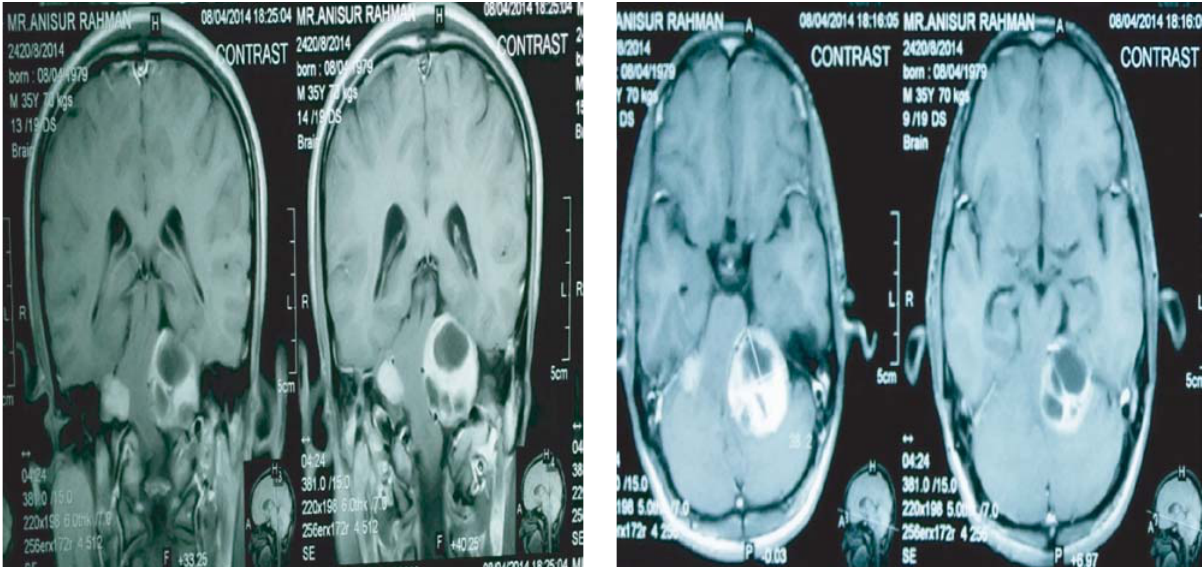
Fig 2. Post-contrast MRI shows well defined, enhancing, large heterogeneous and cystic mass in left CP angle and also a small mass in right CP angle extending in left internal auditory meatus suggesting bilateral acoustic schwannomas